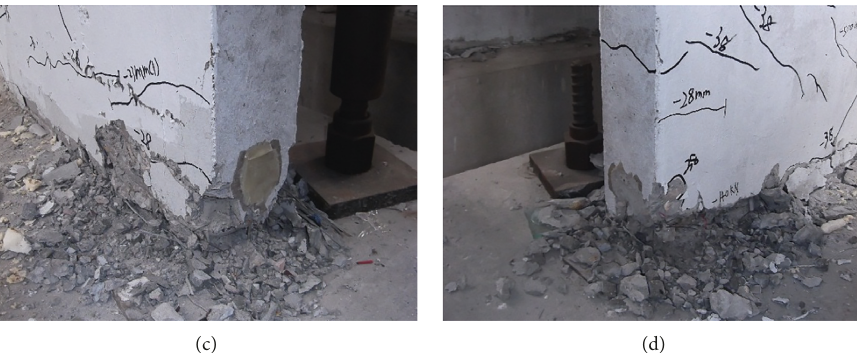
Figure 20: Damage of precast shear walls at the base position. (a) Precast shear wall A. (b) Precast shear wall B. (c) Precast shear wall C. (d) Precast shear wall D.